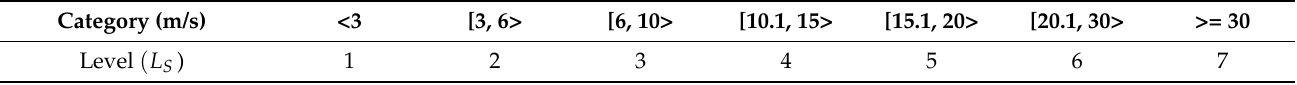
Table 4. Wind speed